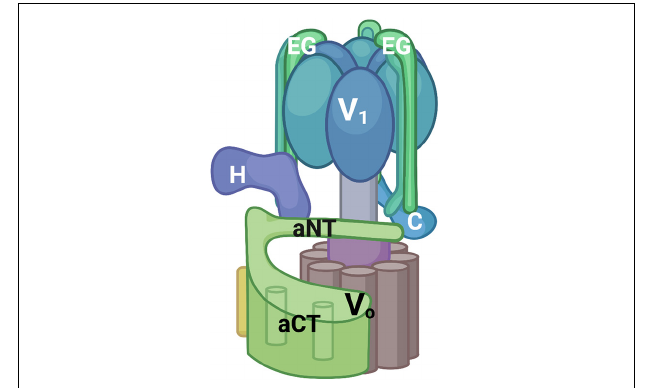
FIGURE 1 | V-ATPase structural model. V-ATPases consist of a peripheral V 1 complex and an integral membrane V o complex, both containing multiple subunits. The V 1 complex contains a hexamer of catalytic and regulatory subunits (in blue, not individually labeled) as well as three peripheral stalks each consisting of an EG heterodimer. Two of these EG heterodimers are labeled and the top of the third is visible at the back of the complex. The C and H subunits help to attach the V 1 subcomplex to V o serve important regulatory roles. The V o subcomplex includes a ring of proteolipid subunits (brown) and the a-subunit. The a-subunit is a two-domain protein with a cytoplasmic domain (aNT) and an integral membrane domain (aCT). All figures were constructed using